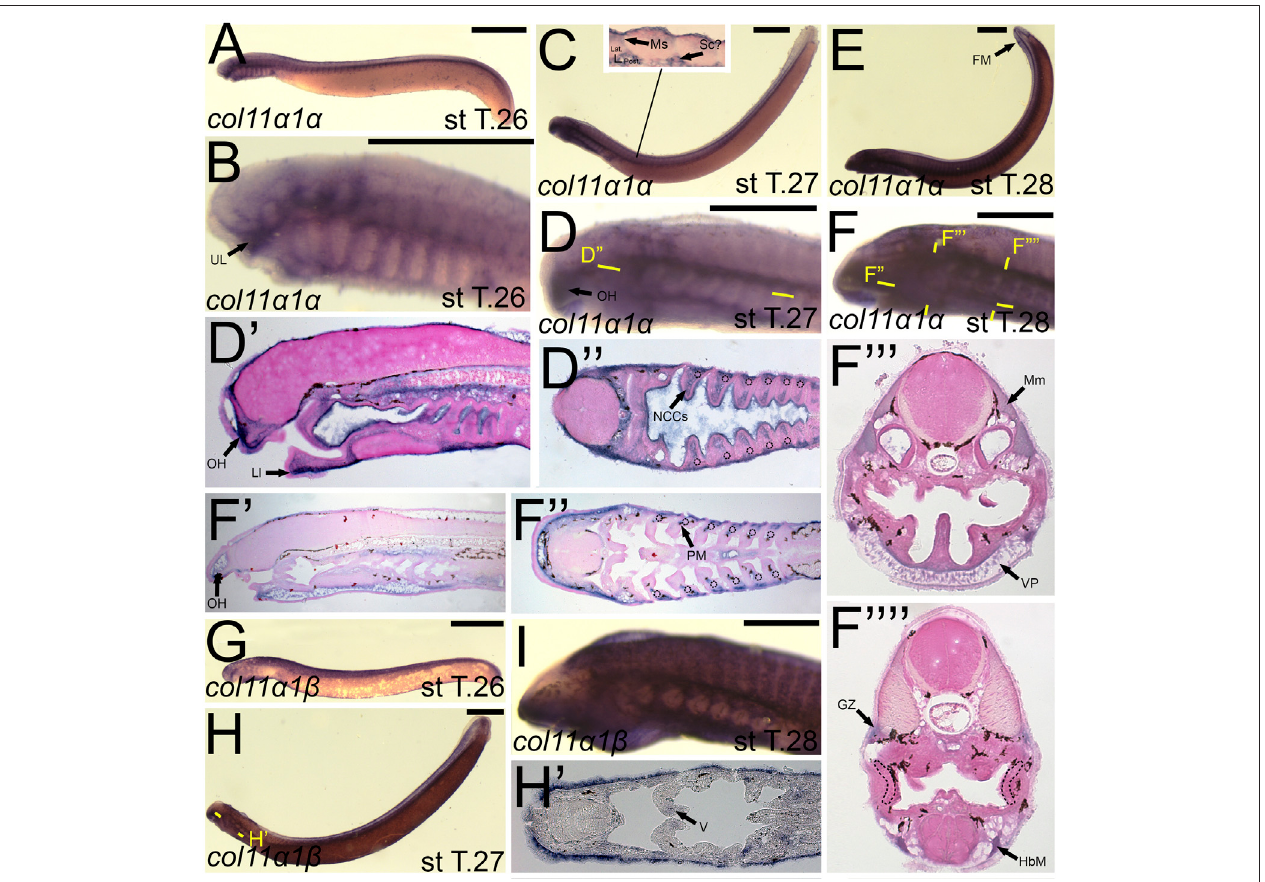
FIGURE 10 | Expression of colB4/col11a1 α and colB5/col11a1 β in larval lamprey. All scale bars are approximately 500 μ m. (A,B) col11a1 α expression was in the cranialgangliaandthemesenchymeofthepharynxandupperandlowerlip. (C,D) col11a1 α expressionwasinthemesenchymeoftheoralhood,lowerlip,and fi nfold,in the myosepta and presumptive sclerotome, and also in the non-skeletogenicneural crest cells in the pharynx. (E,F) col11a1 α expression wasin the mesenchyme of the fi n fold, oral hood, lower lip, and ventral pharynx, the myomeres, hypobranchial musculature, pharyngeal muscles, and myomeres. Dotted circles indicate presumptive branchial arch skeleton. (G,I) col11a1 β expression was super fi cial in the epidermis. (H) col11a1 β expression was in the epidermis and in the medial velum. Keywords:Ep:epidermis;FM: fi nmesenchyme;GZ:growthzone;HbM:hypobranchialmusculature;LL:lowerlip;Mm:myomeres;Ms:myoseptaOH:oralhood;NCCs: neural crest cells; PM: pharyngeal muscle; Sc: sclerotome; UL: upper lip; VP: ventral